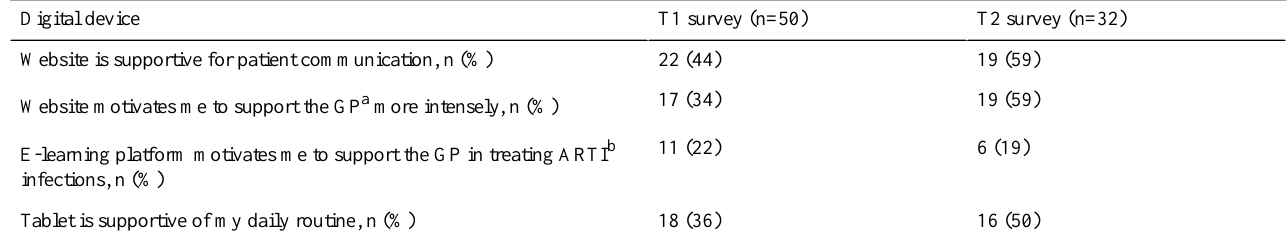
Table 5. Perceptions of the intervention component characteristics by the medical assistants, n